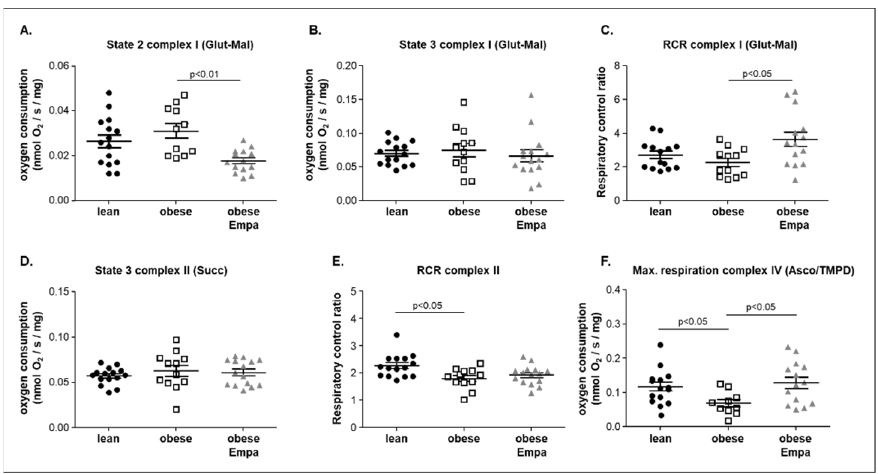
Figure 4. Mitochondrial function was assessed in saponin-skinned muscle fibers of the soleus muscle from ZSF1-lean (lean, black circles), ZSF1-obese (obese, open squares) and ZSF1-obese rats treated with Empagliflozin (obese + Empa, grey triangle) animals. To assess mitochondrial function complex I state 2 ( A ), state 3 ( B ) and the respiratory control ratio (RCR, ( C )) using glutamine (Glut) and malate (Mal) as substrate was measured. For the assessment of complex II, succinate (Succ) was added to the saponin-skinned fibers and state 3 respiration ( D ) and the respiratory control ratio (RCR) ( E ) was quantified. To measure the maximal respiration of complex IV ascorbate (Asco) and the electron-donating compound, tetramethyl-p-phenylene diamine (TMPD) was added after the addition of the mitochondrial uncoupler FCCP ( F ). Results are expressed as mean ± SEM ( n = 12–15 per group).